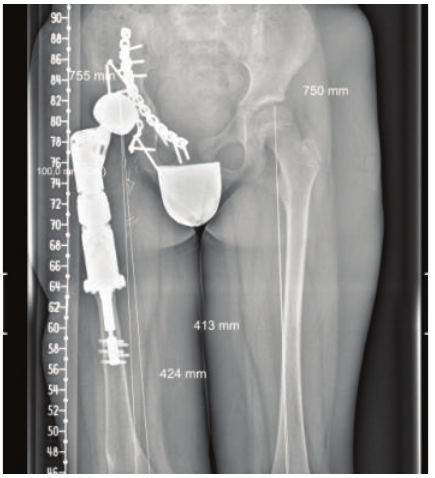
Figure 3: After 18 months of follow-up, a plain AP radiograph of the pelvis shows correct integration of the autograft and